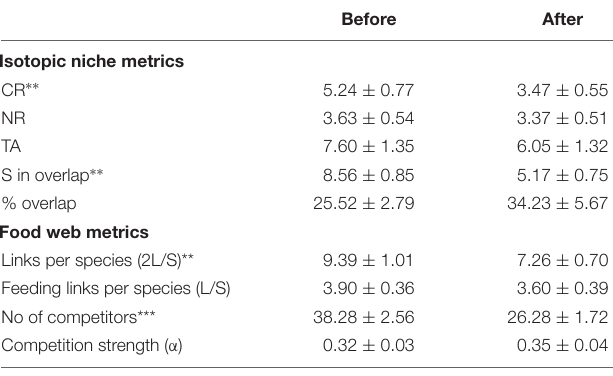
TABLE 2 | Isotopic niche and food web metrics of taxa common to BEFORE and